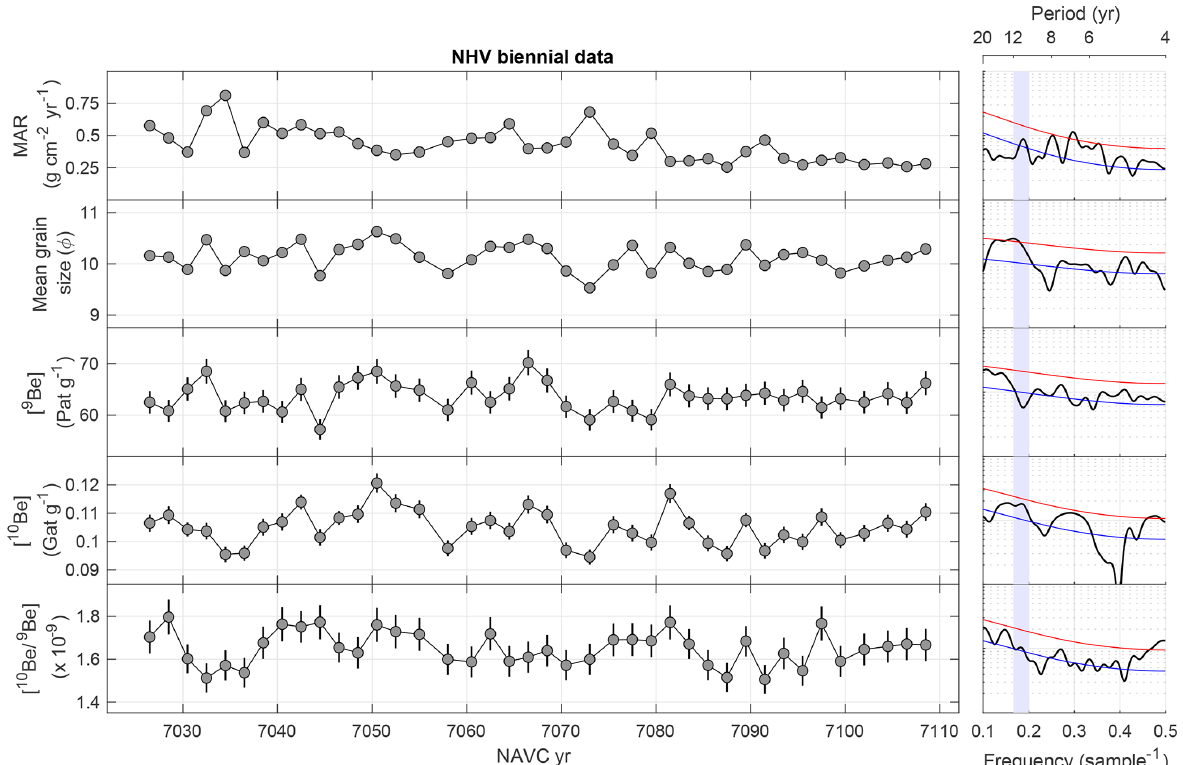
Figure 11. Sedimentological data and Be concentrations for an 80-year record with 2-year resolution from paraglacial varves at the North Haverhill (NHV) site. The mass accumulation rate (MAR) is calculated from varve thickness and the density–grain size relationship shown in Fig. 3. Plots at right show results of multitaper method (MTM) spectral analysis of the observational data series using the SSA-MTM Toolkit (Dettinger et al., 1995; Ghil et al., 2002), highlighting frequencies in the vicinity of the 11-year Schwabe solar cycle. Blue and red lines show the 50% and 90% significance thresholds, respectively, relative to an AR(1) red noise estimate, and the shaded area highlights the 11-year solar cycle